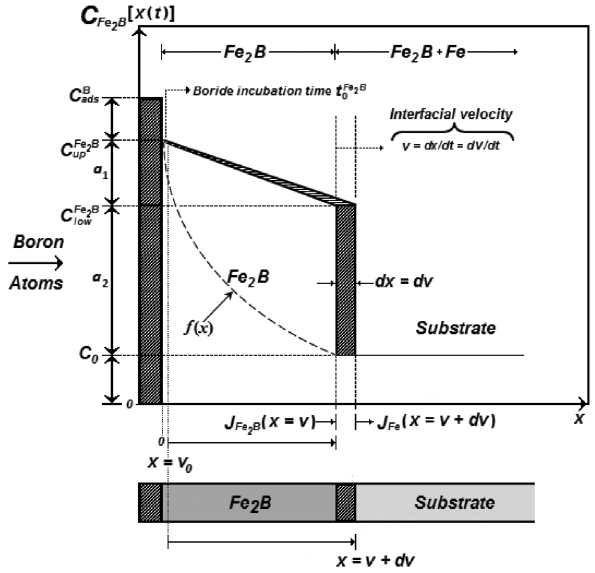
Fig. 1: A schematic boron-concentration profile through the Fe 2 B